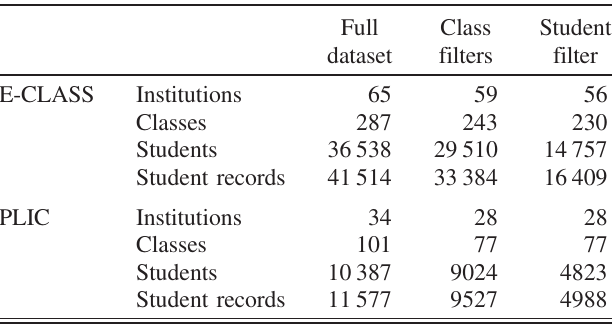
TABLE III. Number of institutions, classes, students, and student records included in the PLIC and E-CLASS datasets following each round of the data filtering process. We define a class as a combination of course (e.g., Physics 101) and semester (e.g., Fall 2019), so a single course may administer the E-CLASS or PLIC in multiple semesters and count as multiple classes. Students that took an assessment in different classes are counted multiple times in the student records tally. In the main text, we refer to student records as students and use these data in our